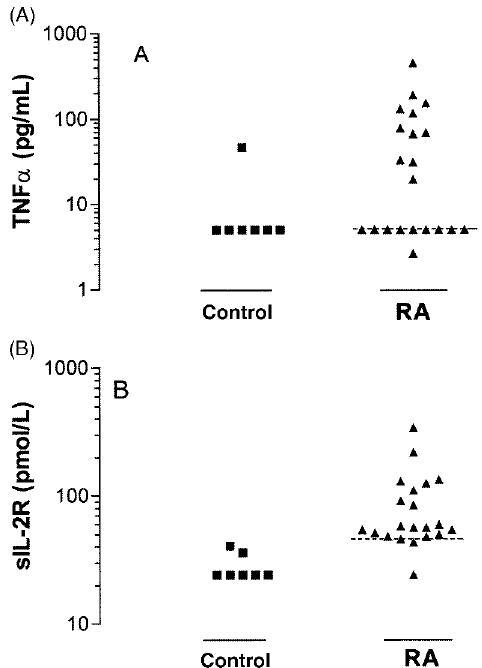
FIG. 2. Individual values of TNF- a (A) and sIL-2R (B) in both control and RA groups. The dotted line indicates the